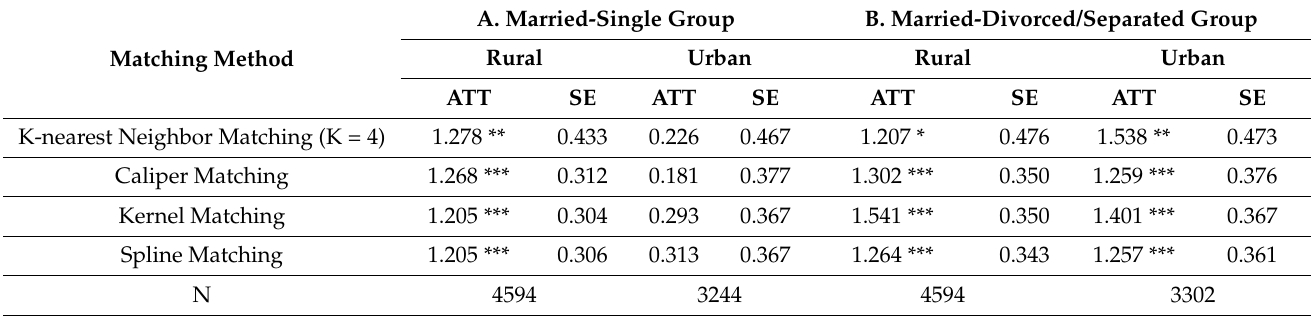
Table 4. Heterogeneous effects of region.